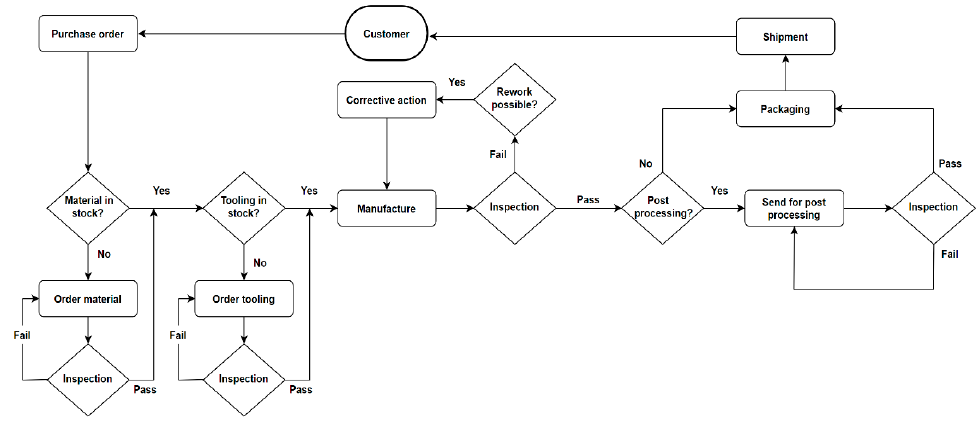
Figure 7. Sample flow chart of operations.